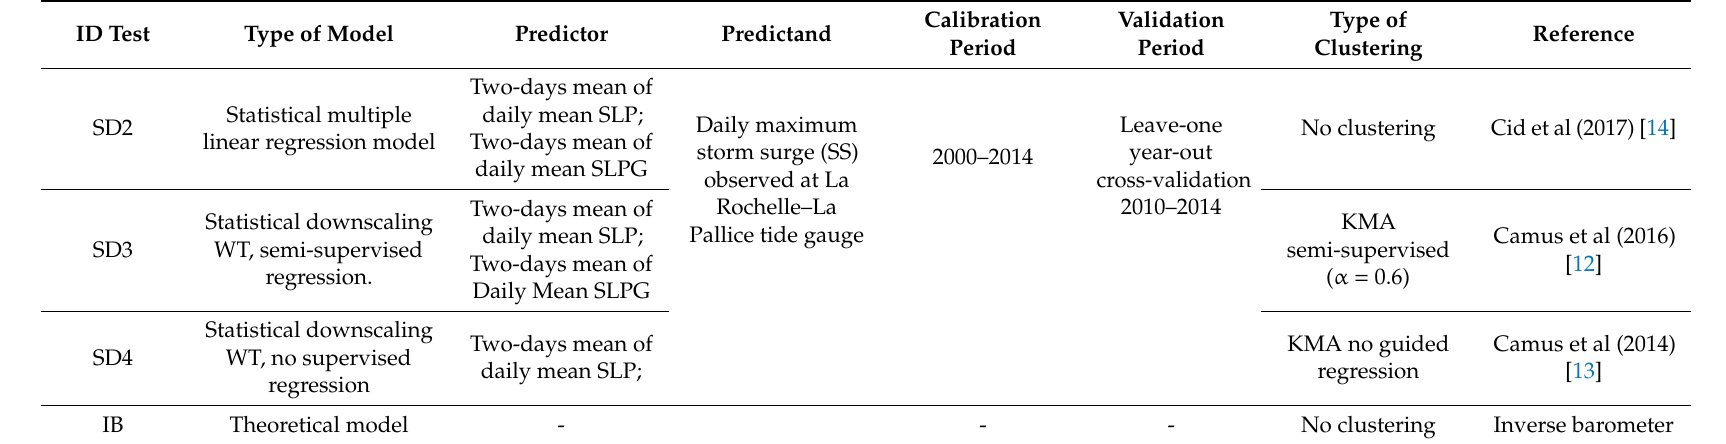
Table 2. Configuration of each model tested in sensitivity